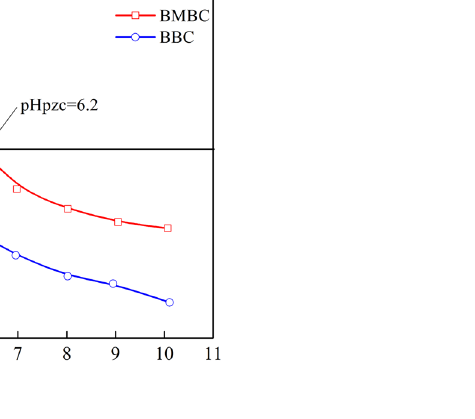
Figure 2. Zeta potential of BMBC as a function of